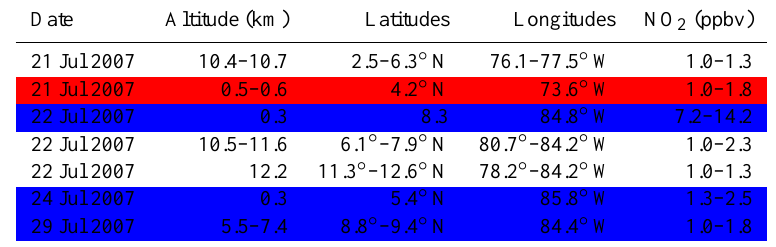
Table 5. Measurements of NO 2 > 1ppbv, > 50km away from Alajuela, Costa Rica airport (10.0 ◦ N, 84.2 ◦ W) from DC-8 flights during TC4. Enhanced NO < 8km are highlighted orange over Columbia and blue over open